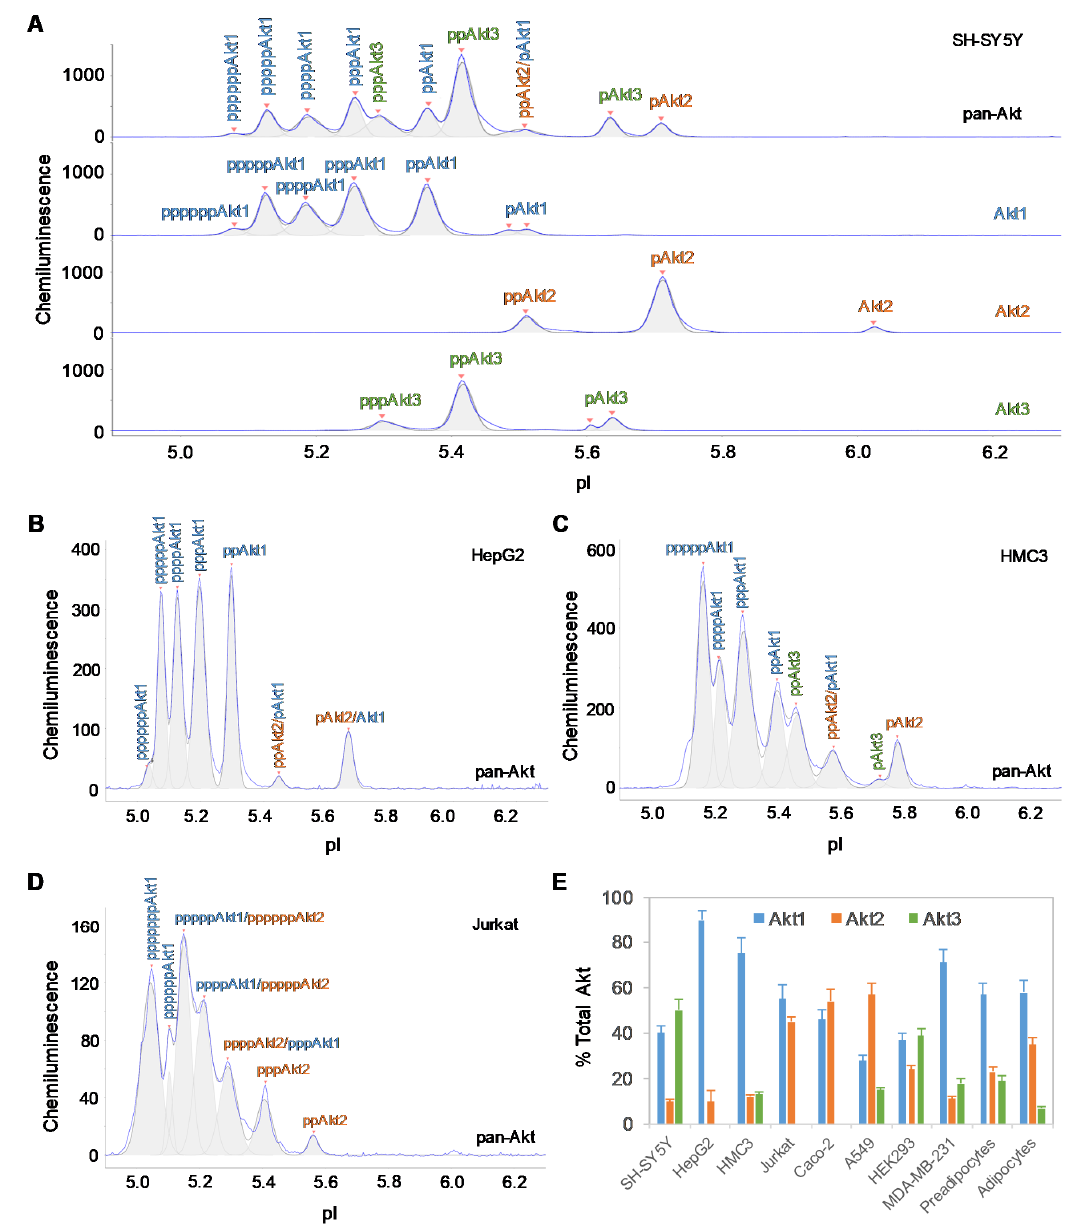
Figure 1. Tissue-specific expression of Akt isoforms. ( A ) Akt isoform identification in SH-SY5Y cell lysates using capillary isoelectric focusing (cIEF) immunoassays. Primary antibodies against pan-Akt (top panel), Akt1 (second panel), Akt2 (third panel), and Akt3 (fourth panel) were used. Identities of Akt isoforms in ( B ) HepG2 cells, ( C ) HMC3 cells, and ( D ) Jurkat cells on cIEF electropherograms. Peaks associated with Akt isoforms are labeled and color-coded: Akt1 (blue), Akt2 (orange), and Akt3 (green). ( E ) Expression levels of Akt isoforms as percentages of total Akt expression level in ten different cell types. The error bars indicate the standard deviations of six repeated measurements per experimental condition.